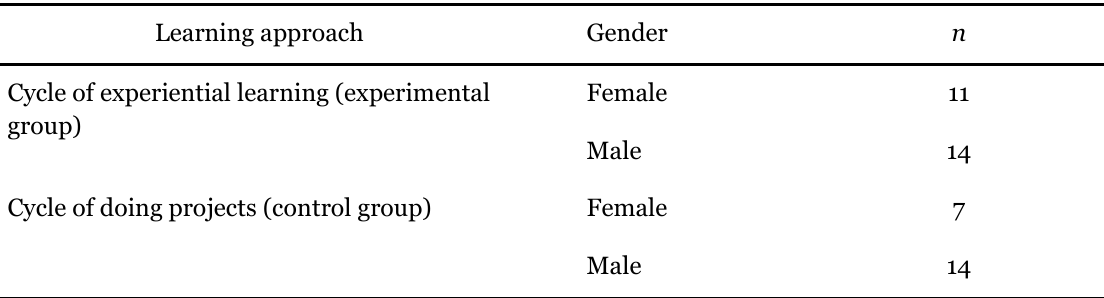
Gender and Number of Participants in Learning Approach